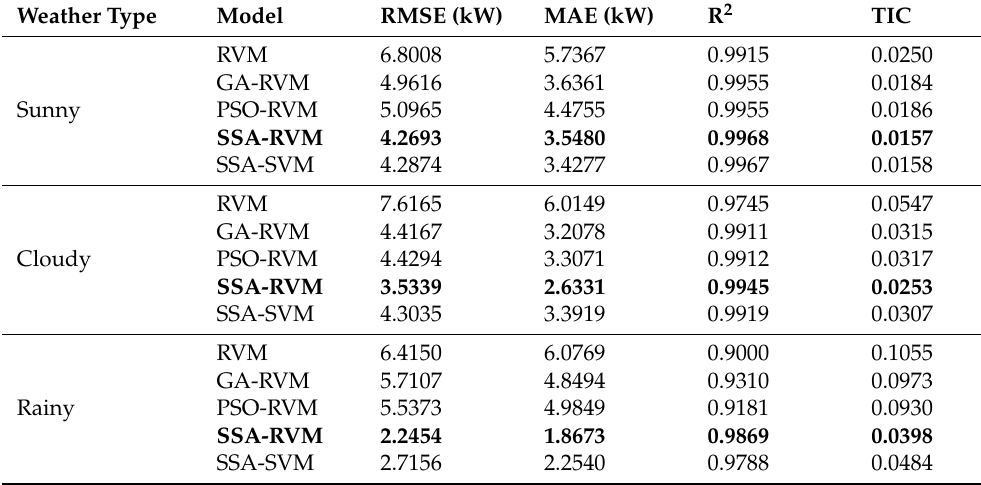
Table 4. Results of evaluation indexes of different methods with different weather types in